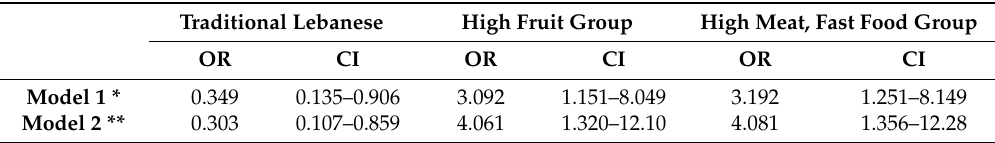
Figure 3. Distribution of participants according to the different dietary patterns, BMI, and gender.